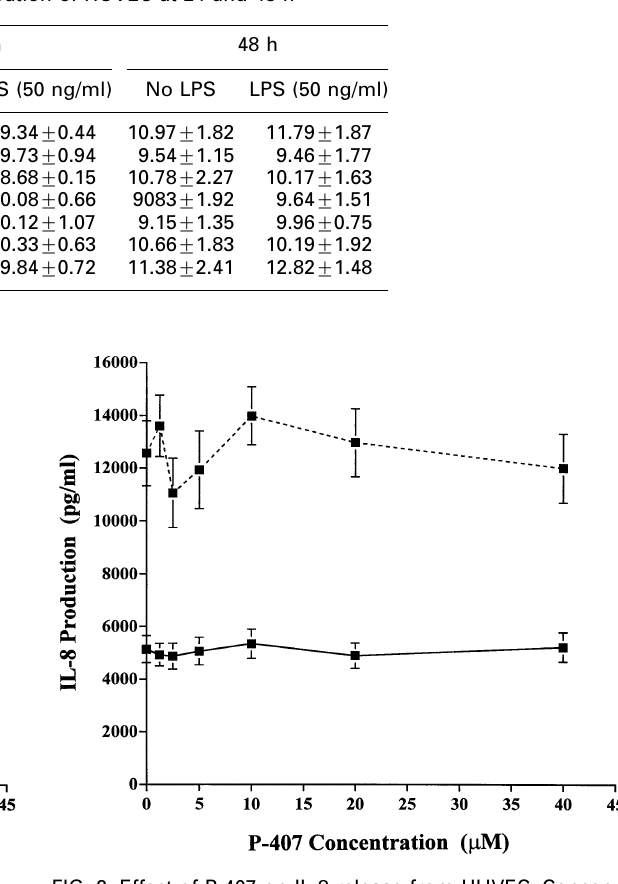
FIG. 1. Effect of P-407 on IL-6 release from HUVEC. Concen- tration of IL-6 in the absence of LPS at 24 h (solid line, j ) and 48 h (solid line, m ), and in the presence of LPS (50 ng/ml) at 24 h (dashed line, j ) and 48 hr (dashed line, m ).